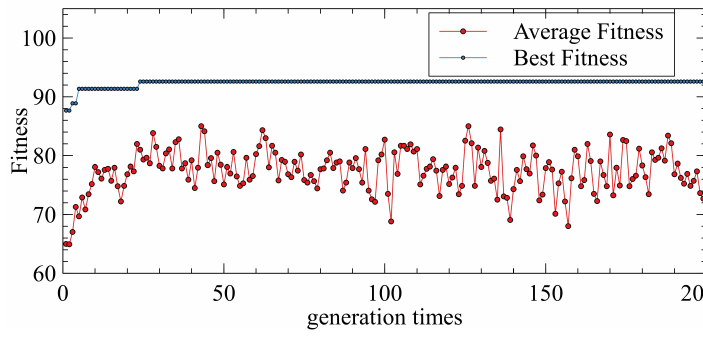
Figure 17. PSO algorithm result.